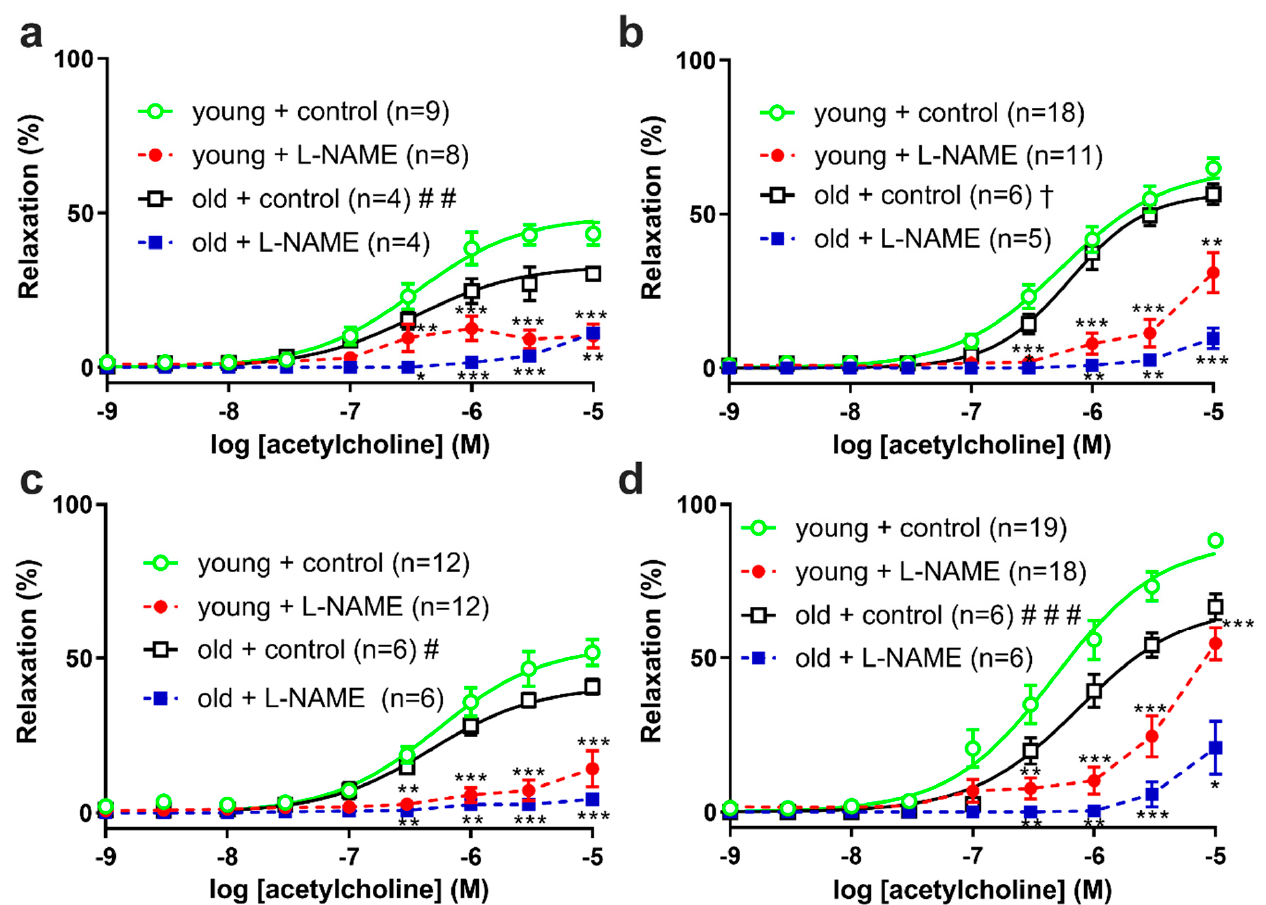
Figure 4. Acetylcholine-induced relaxations of ( a ) proximal, ( b ) middle, ( c ) distal saphenous artery segments, and ( d ) caudal branches from (circle symbols) young and (square symbols) old Sprague Dawley rats. The results are expressed as mean ± S.E.M of ( n ) rats. Lines represent best-fit four parameter sigmoidal dose response curves for controls. Differences in best-fit curve parameters for controls were compared by Student’s t -test. # p < 0.05, ## p < 0.01, ### p < 0.001, vs. E max young; † p < 0.05, vs. nH young. Differences in relaxations in control vs. L-NAME treatment were compared by 2-way ANOVA with Bonferroni post hoc. * p < 0.05, ** p < 0.01, *** p < 0.001, vs. age-matched control.